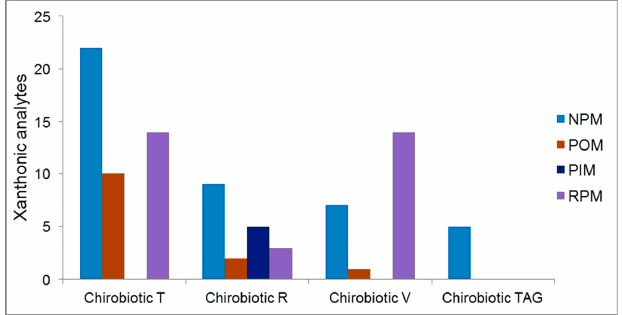
Figure 7. Comparative performance of Chirobiotic TM T, R, V and TAG for baseline enantioseparation of xanthonic analytes under multimodal elution conditions.